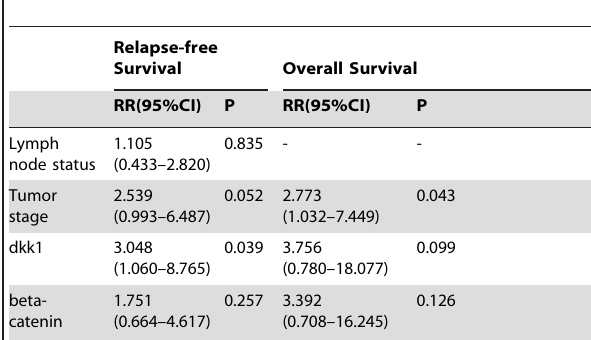
Table 4. Multivariate analysis of prognostic factors and adjuvant treatments for breast cancer